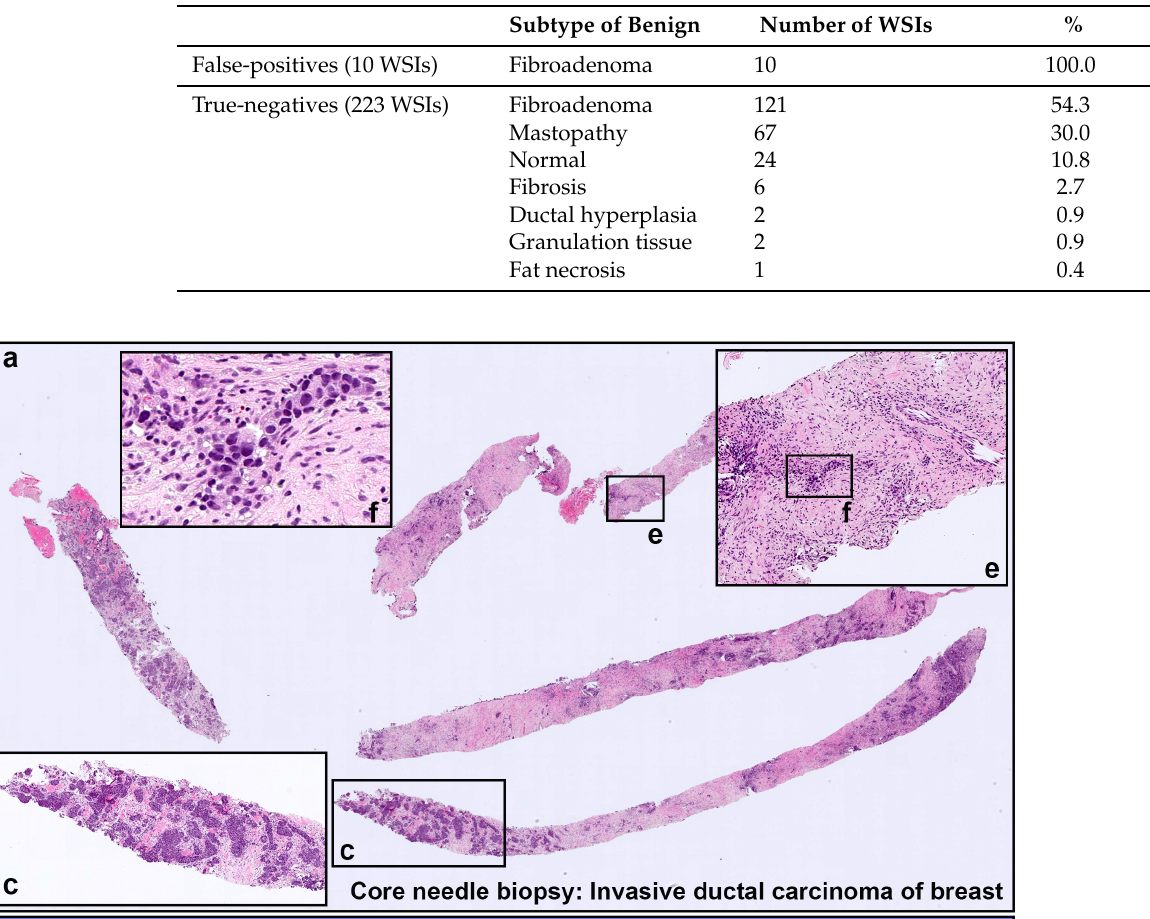
Table 3. A breakdown of the subtypes of the false positives and true negatives in the biopsy test set using the TL model x10 using a classification threshold of 0.5.